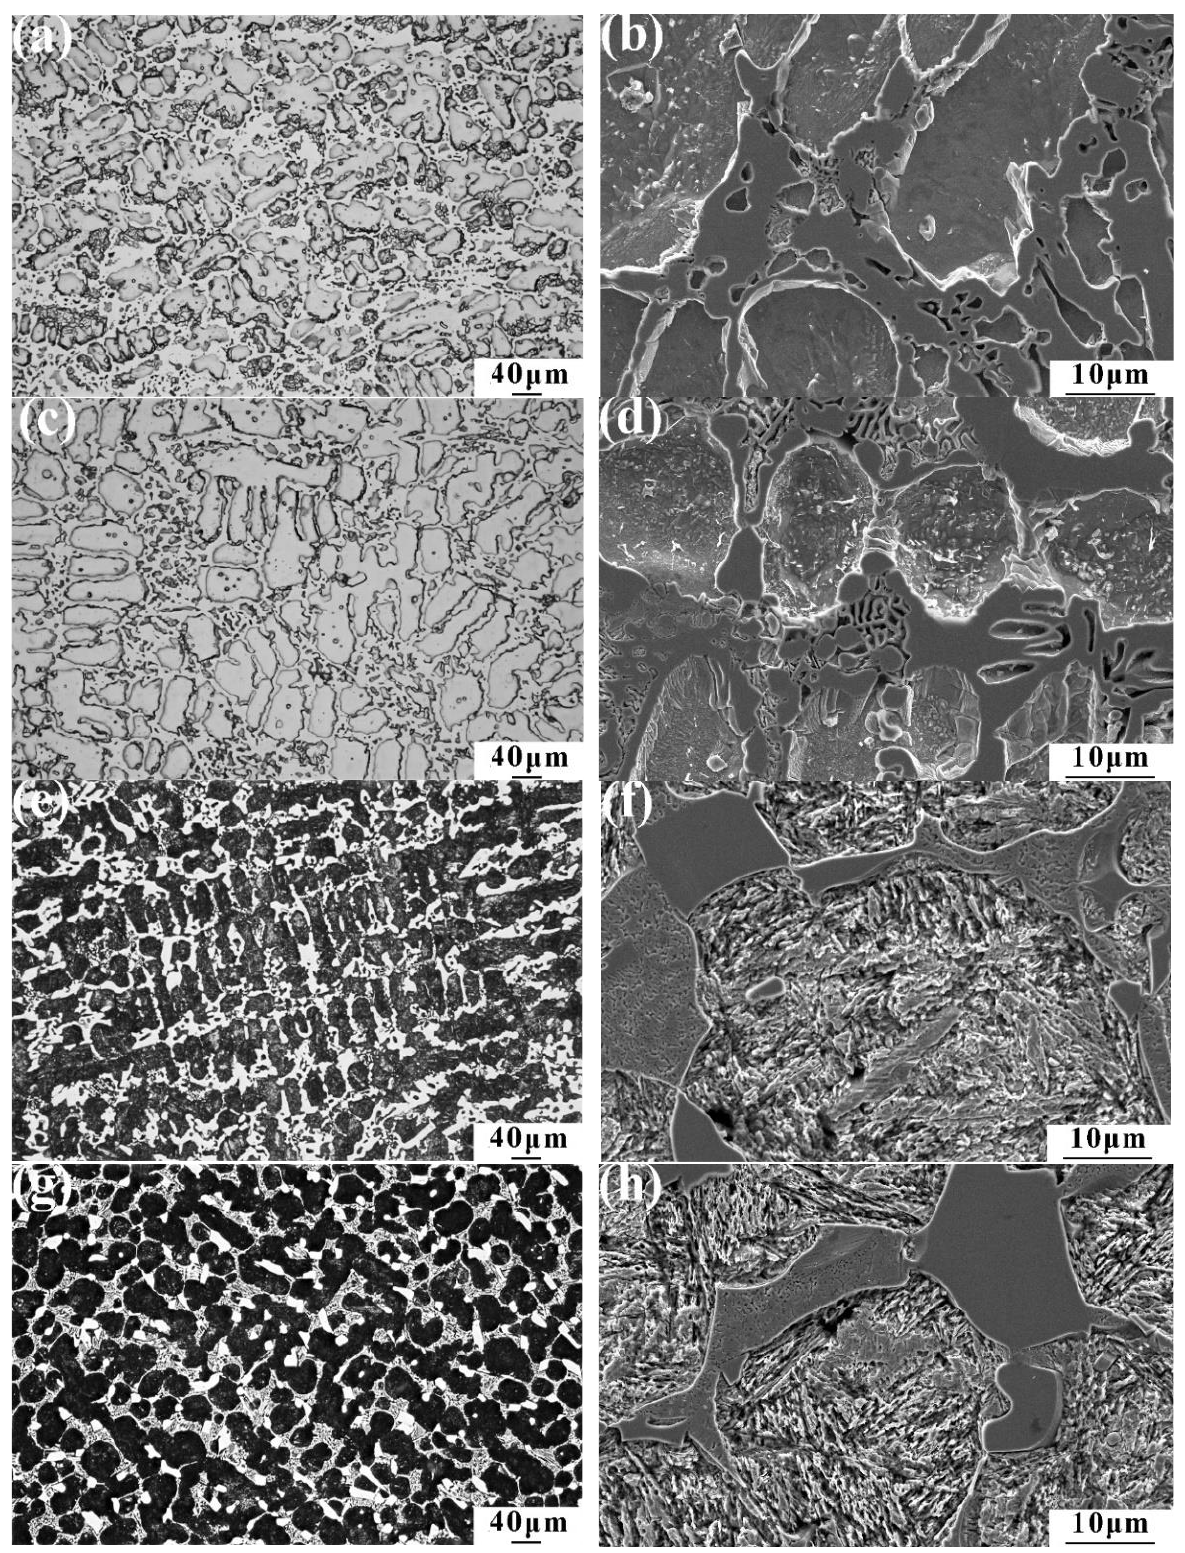
Figure 4. Microstructures of alloy A quenched at different temperature (°C): ( a , b ) 960; ( c , d ) 1000; ( e , f ) 1040; ( g , h ) 1080.